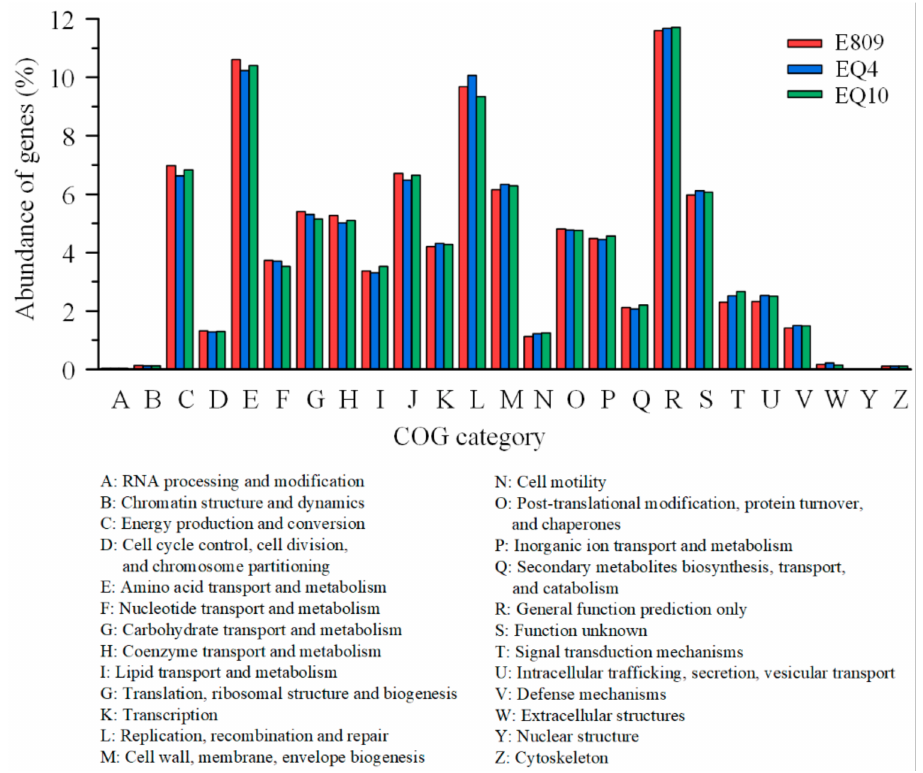
Figure 4. The predicted genes in the metagenome were matched to the functional categories in the COG